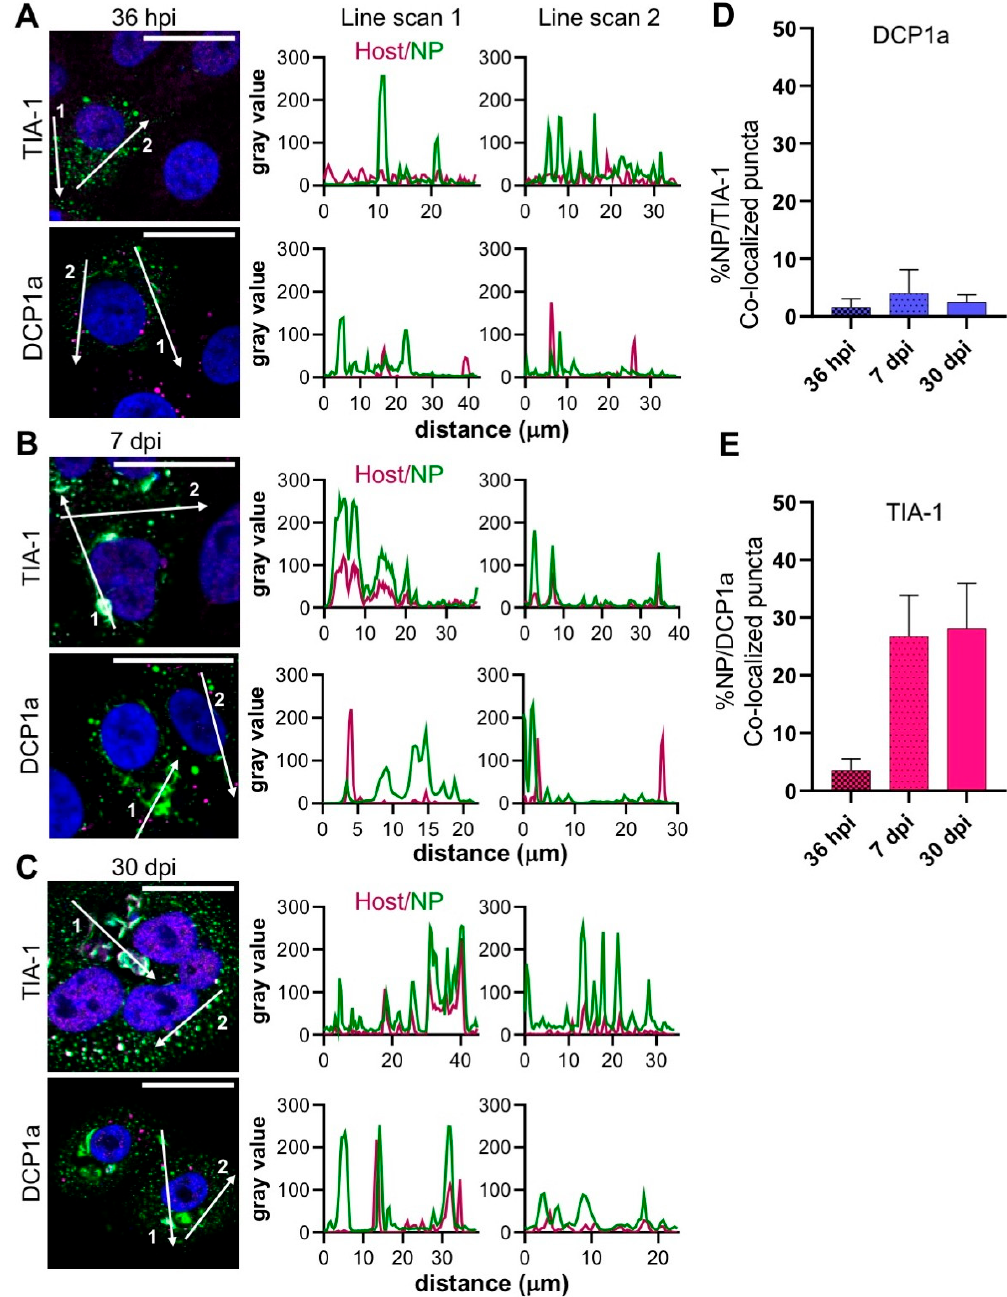
Figure 4. Co-localisation between TULV NP and either the stress granules (SGs) or the processing bodies (PBs) at the early, peak and persistent stages of TULV infection in Vero E6 cells. The spatial distribution of the SG marker TIA-1 and the PB marker DCP1a (magenta) was observed alongside TULV NP (green) in Vero E6 cells infected with TULV at a MOI of 0.1 by confocal microscopy at 40× magnification at the following time points; ( A ) 36 h post infection (hpi), ( B ) 7 days post infection (dpi) and ( C ) 30 dpi. The scale bars represent 30 µm. Fluorescent line scans were taken using Fiji software with the designated number labels corresponding to the adjacent line scan plots. Nuclei were stained with DAPI (blue), TULV NP was detected using NP antisera, and the SGs and PBs were detected using specific antisera against TIA-1 and DCP1a, respectively. Percentage co-localization of D) TIA-1 and E) DCP1a puncta co-localizing with NP at all three time points were quantified and represented as separate histograms. Images shown in panels A, B and C show a representative analysis of 7, 25 and 23 cells, respectively.